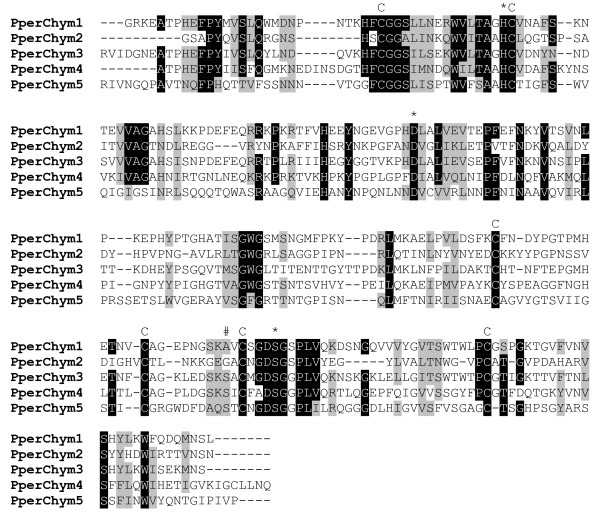
Multiple sequence alignment of putative P. perniciosus chymotrypsins (partial sequences). Conserved cysteines are indicated (C), catalytic H/D/S residues marked by (*) and a serine residue implicated in chymotrypsin substrate specificity marked by (#). Accession numbers: PperChym1 [GenBank:EZ933296], PperChym2 [GenBank:EZ933297], PperChym3 [GenBank:EZ933298], PperChym4 [GenBank:EZ933299], PperChym5 [GenBank:EZ933300].